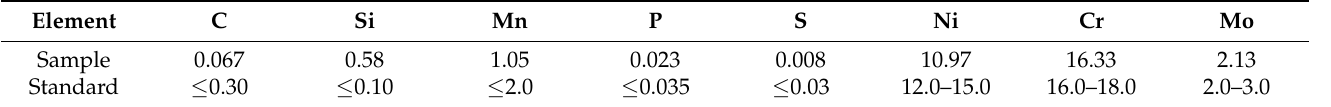
Table 2. Chemical composition analysis (wt.%).